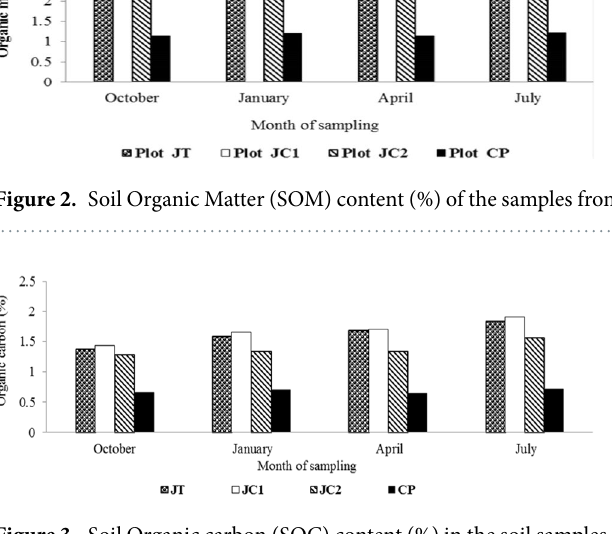
Figure 3. Soil Organic carbon (SOC) content (%) in the soil samples.